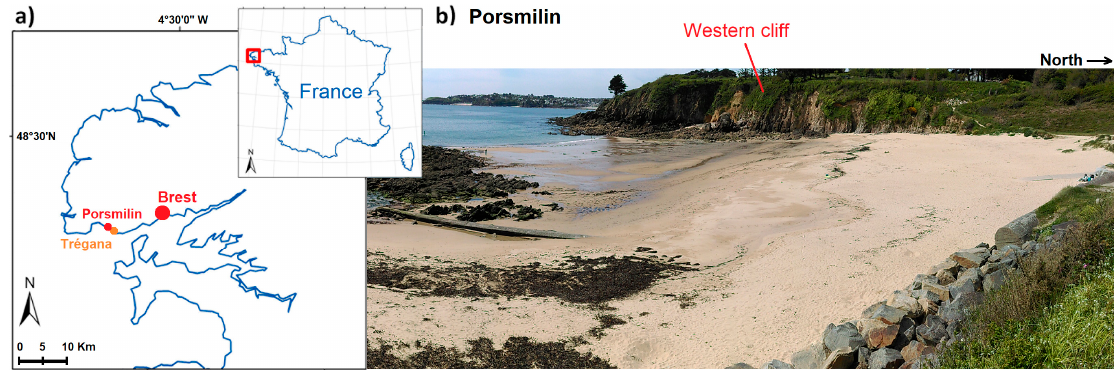
Figure 1. ( a ) Localization of Porsmilin beach and ( b ) surrounding cli ff s at the entrance of the Bay of Figure 1. Localization of Porsmilin beach and surrounding cliffs at the entrance of the Bay of Brest in Brest in Brittany, Brittany, France.